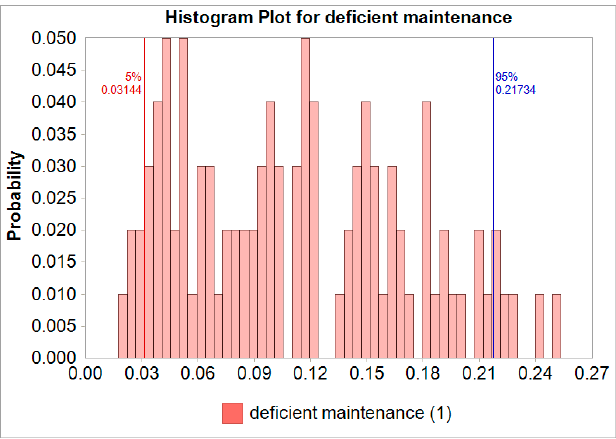
Figure 8. Sensitivity analysis (Probability distribution for input variable).